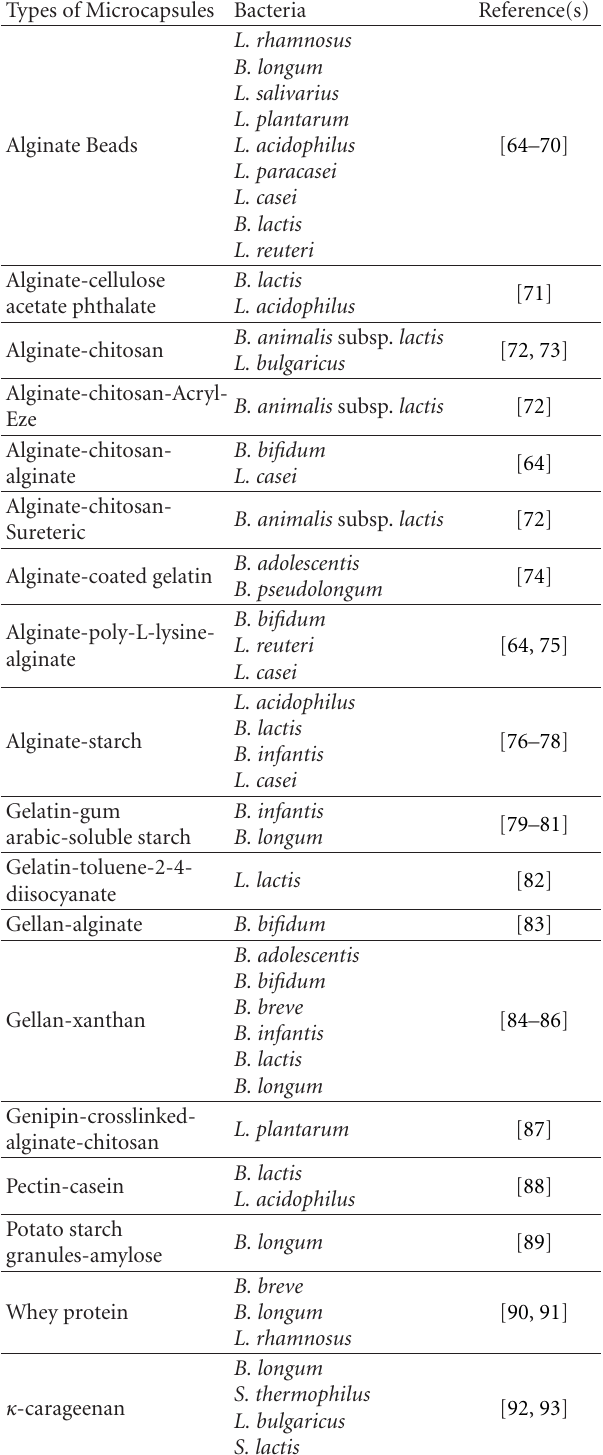
Table 1: Types of microcapsules available for the targeted delivery of probiotic